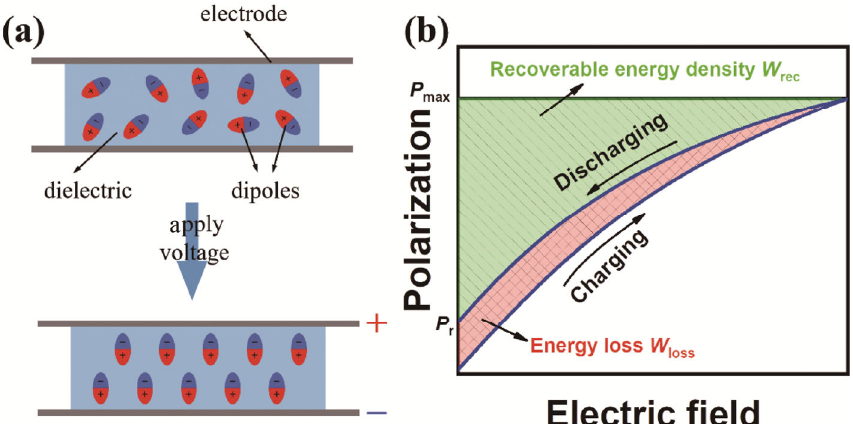
Fig. 2 (a) Schematic of a dielectric between two electrodes before and after applying an external voltage. Reproduced with permission from Ref. [13], © Elsevier Ltd. 2021. (b) Calculation of the energy-storage performance of a